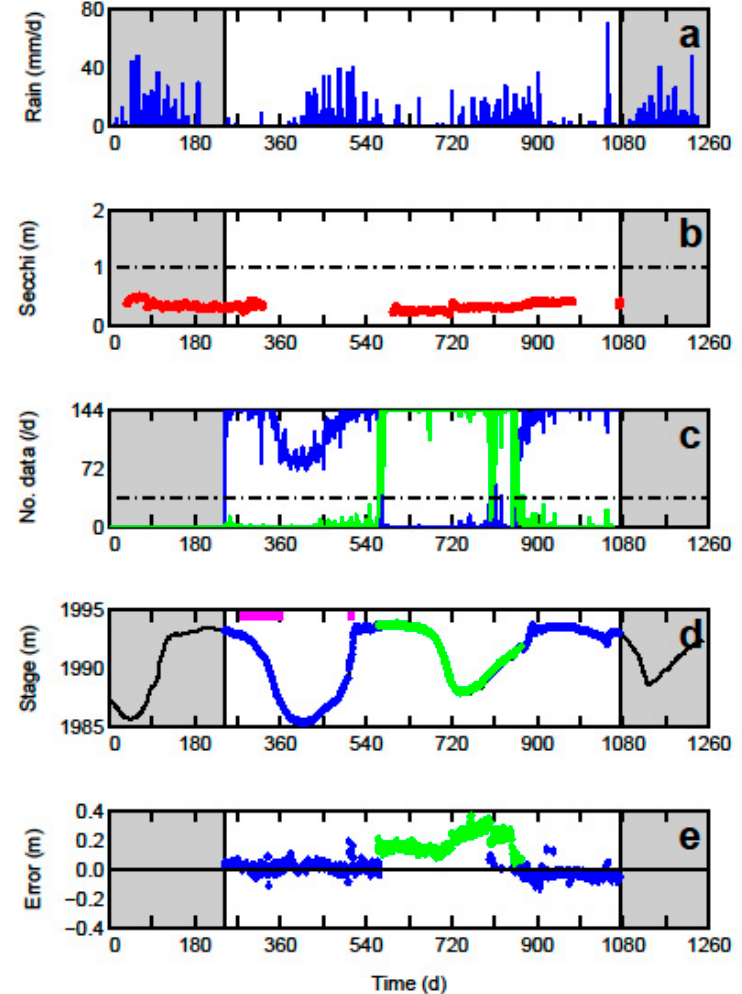
Figure 9. Main results from the field experiment at Cointzio: ( a ) rain; ( b ) water transparency; ( c ) daily number of available Lidar data to estimate a stage value (blue line shows data associated with a water surface and green line shows data associated with floating objects); ( d ) stage data obtained with the reference (black line) and the proposed Lidar technique (symbols with colors similar to the previous sub-plot; the horizontal purple lines show the calibration periods); ( e ) error of the proposed technique (i.e., stage estimates minus reference values). Day "0" corresponds to 10 May 2012. Grey areas correspond to periods with a failure in the datalogging system.